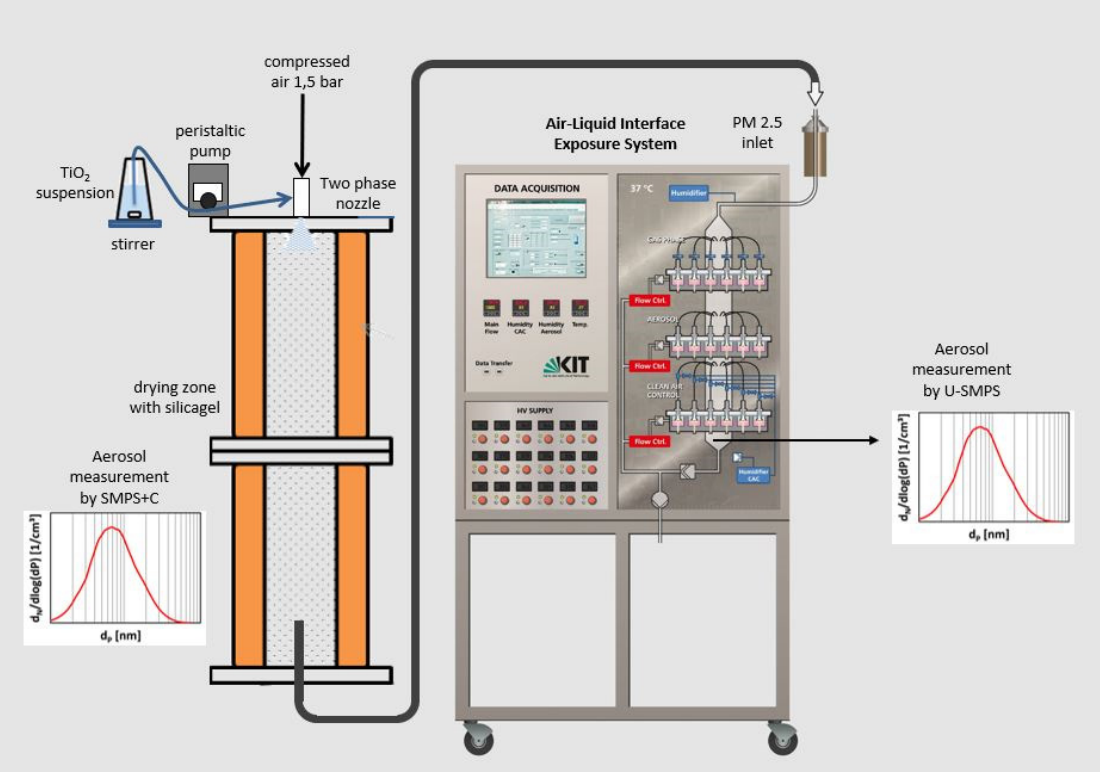
Figure 1. Experimental setup: generation of airborne TiO 2 agglomerates in dry air according to VDI guideline 3491 and exposure of human lung cells in the Air–Liquid-Interface Exposure System with accompanying measurement of particle size distribution using Scanning Mobility Particle Sizer (SMPS) at the dry stage in the reactor as well as for the aerosol inside the exposure